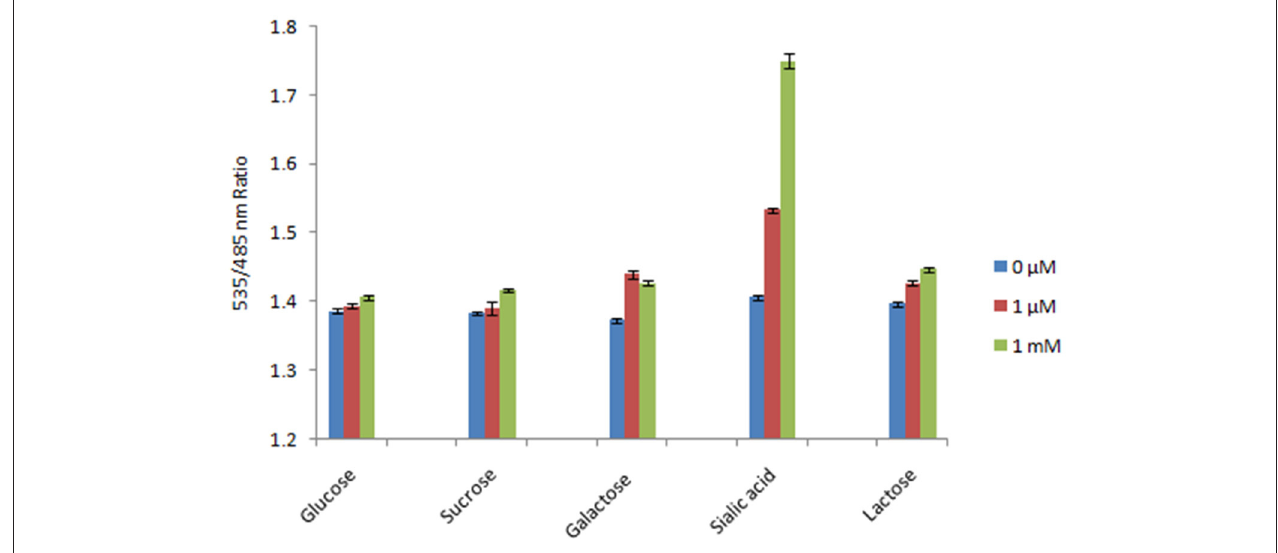
FIGURE 5 | Specificity analysis of FLIP-SA. The specificity of the sensor was recorded based on the changes in FRET ratio after the addition of NeuAc and other sugars at 0 µ M, 1.0 µ M, and 1.0mM. The data are the average of three replications. Vertical bars show the standard errors. 0.20 mg/ml sensor protein was taken.